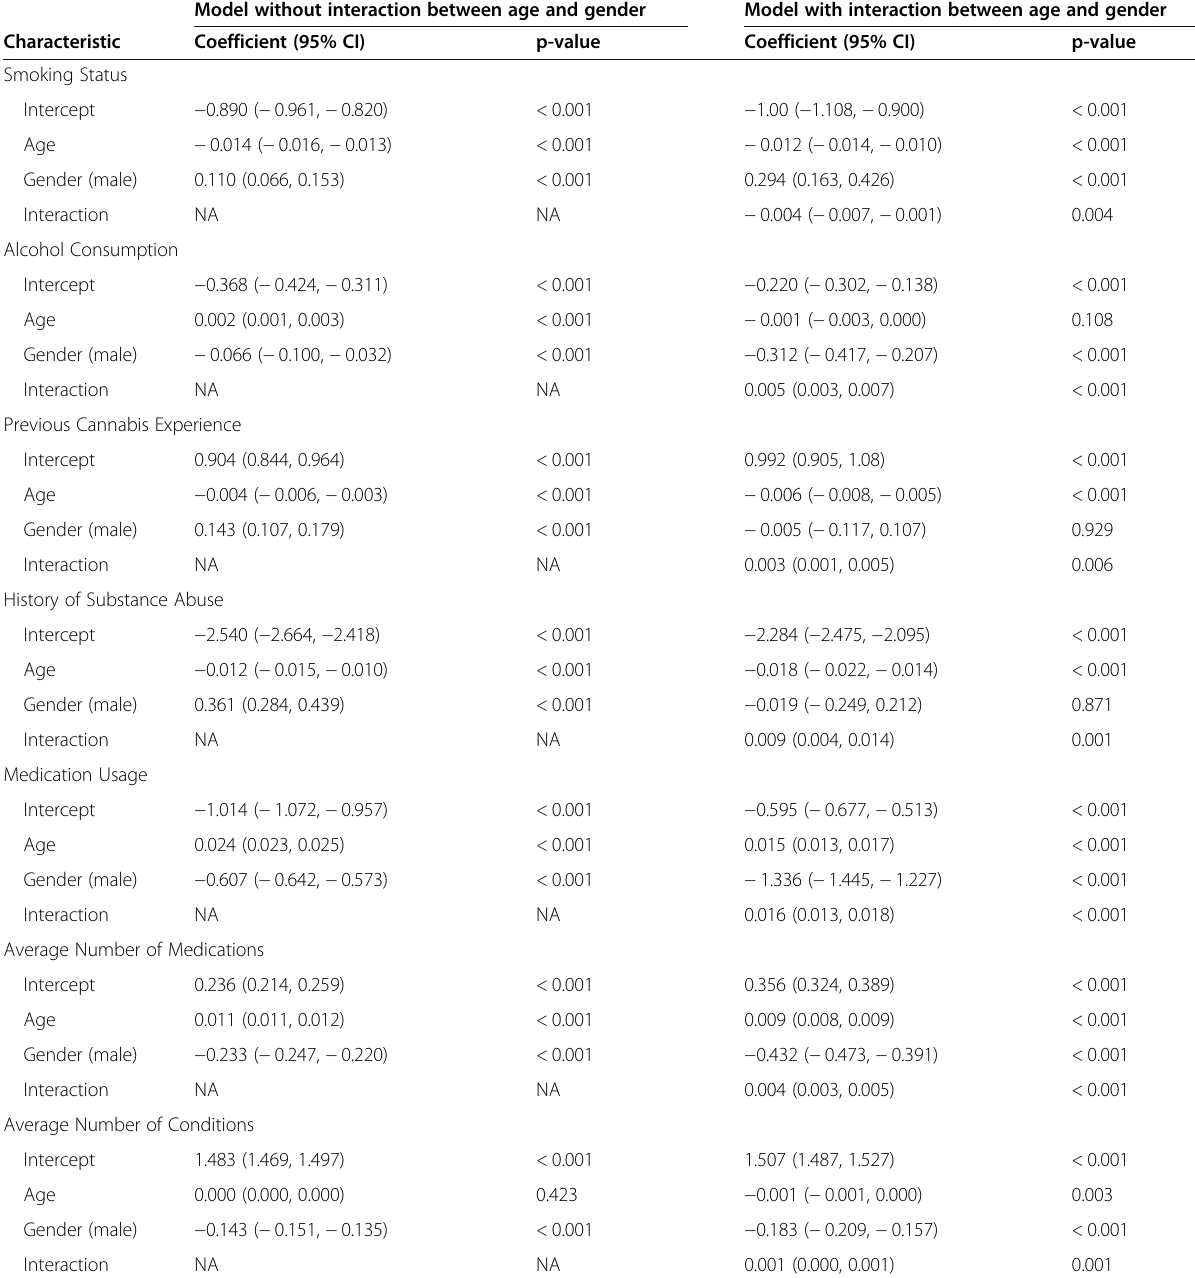
Table 4 shows the results of regression analysis for age and gender as predictors for variables analyzed with univariate analysis in Tables 2 and 3 among 56,860 patients for whom gender was reported. Results are presented with and without an interaction between age and gender included in the model. The coefficient column represents the magnitude of effect and direction of the predictor variable; a negative coefficient for age suggests that younger patients are more likely to report the characteristic, and a negative coefficient for gender suggests that females are more likely to report the characteristic. CI confidence